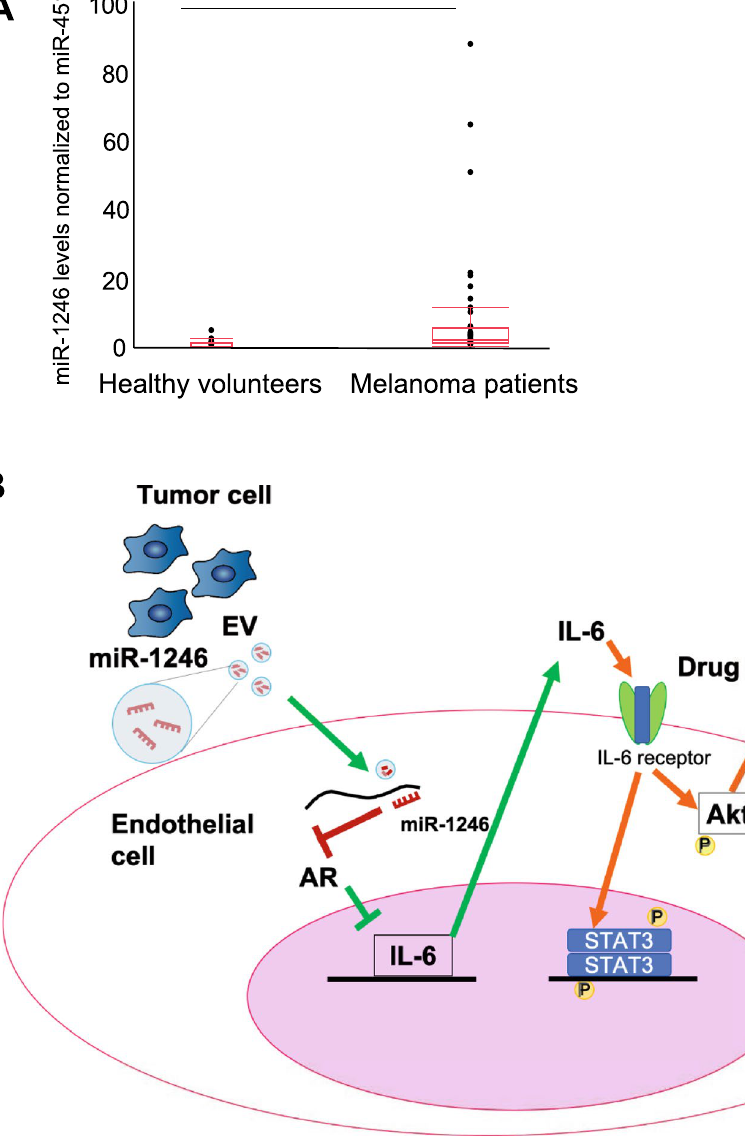
Figure 6. miR-1246 levels in EVs in plasma, and a schematic diagram of the study. ( A ) miR-1246 levels in EVs in healthy volunteers (n = 20) and melanoma patients (n = 42) were determined through real-time PCR (* P < 0.01 vs. healthy volunteers, two-sided Student’s t -test; data are presented as mean ± SD, n = 3 real-time RT-PCR runs). ( B ) A schematic diagram of the study. miR-1246 in tumor EVs was taken into endothelial cells, and AR expression was inhibited, which induced IL-6 secretion and caused drug resistance in an autocrine manner through STAT3 and Akt